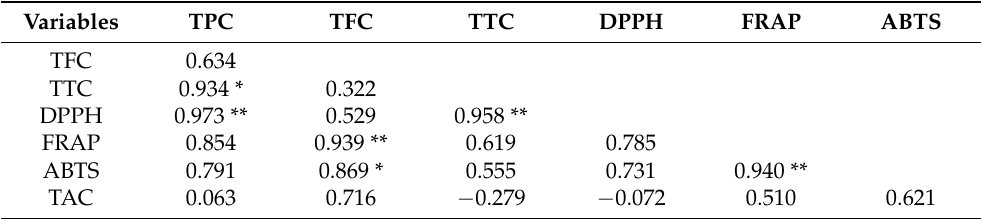
Table 2. Pearson’s correlation between antioxidant capacity by different antioxidant assays. Variables TPC TFC TTC DPPH FRAP ABTS TFC 0.634 TTC 0.934 * 0.322 DPPH 0.973 ** 0.529 0.958 ** FRAP 0.854 0.939 ** 0.619 0.785 ABTS 0.791 0.869 * 0.555 0.731 0.940 ** TAC 0.063 0.716 − 0.279